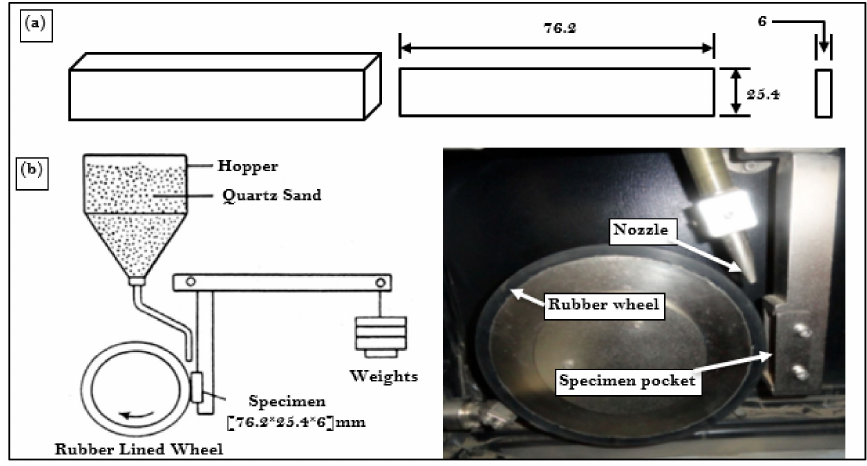
Figure 3. Schematic view of ( a ) abrasive wear test specimen and ( b ) dry sand abrasion test